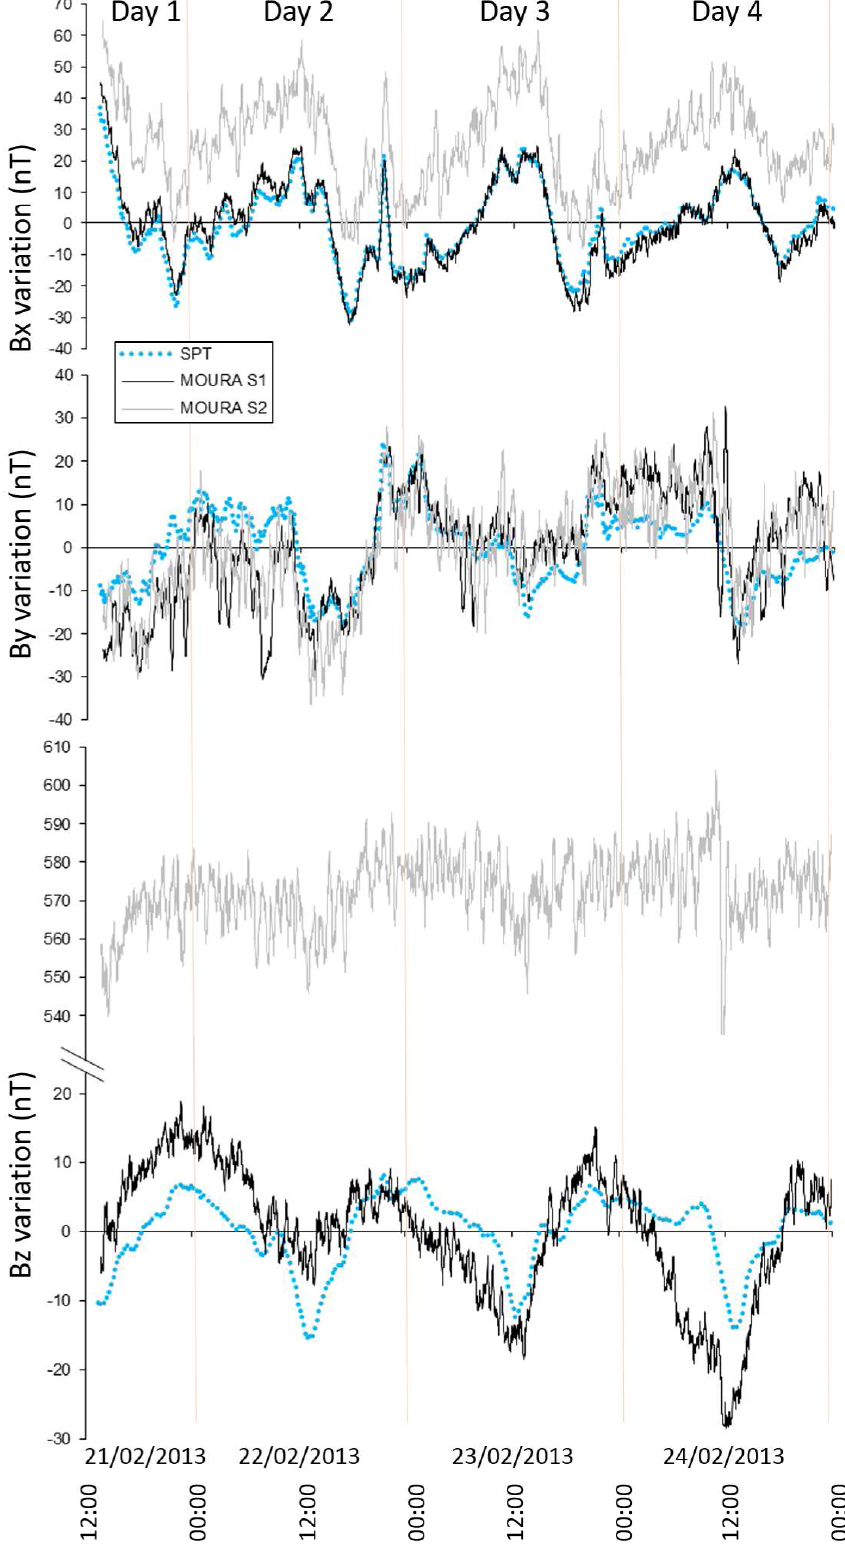
Figure 14. Comparison between measurements from SPT and MOURA, x axis (bottom panel), y axis (middle panel) and z axis (top